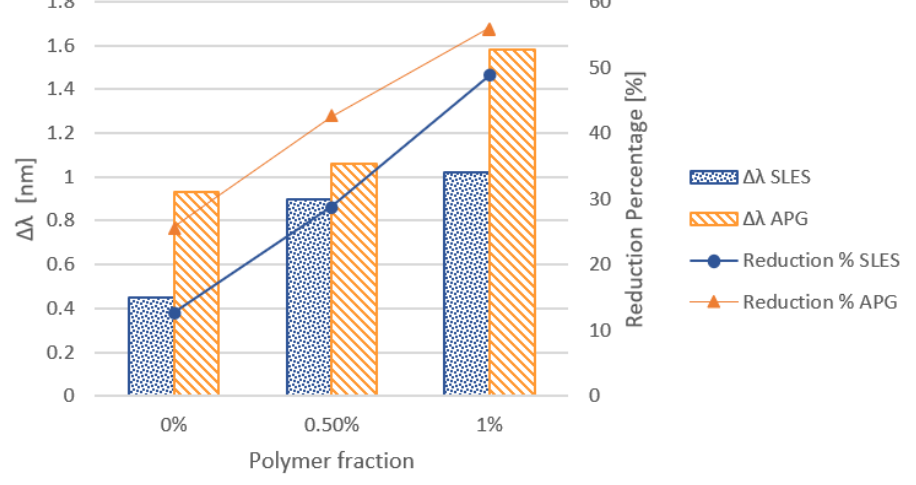
Figure 11. Correlation between the deposition and wet combing reduction percentage for samples with different levels of polymer, formulated with both SLES/CAPB and APG/CAPB at 12 wt. % at room temperature and pH ~7.